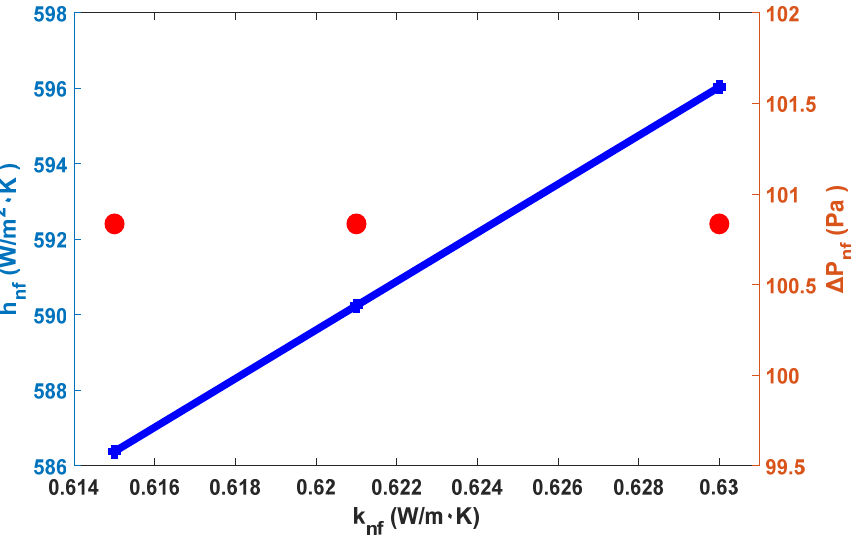
Figure 10. Heat transfer coefficient and pressure drop versus thermal conductivity enhancement (blue line represents heat transfer coefficient and red points represent pressure drop).